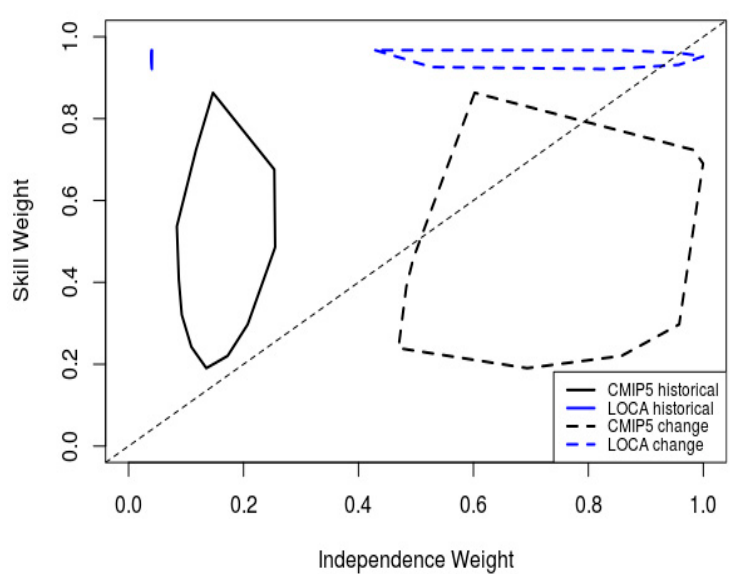
Figure 3. Skill and Independence weights for the CMIP5 (black) and LOCA (blue) ensemble. The solid lines are for the ensembles using only historical precipitation information (SI-h). The dashed lines make use of the projected change in precipitation to derive independence weights and historical accuracy to derive skill weights (SI-c). The individual weights for each ensemble member are contained within each polygon.